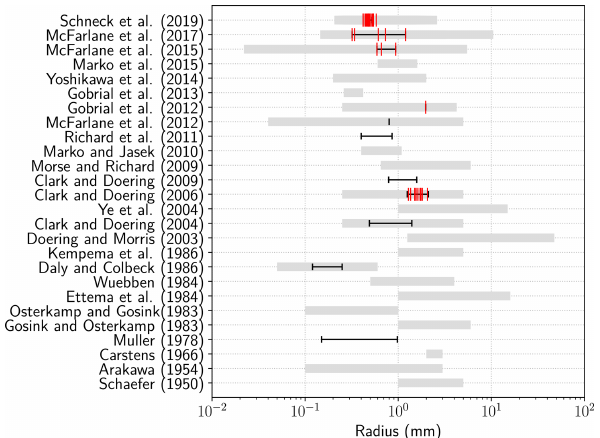
Figure 3. Particle-size ranges (thick grey line), mean range (thin dark line) and log-normal distributions’ mean radius (red vertical ticks) reported in field or laboratory experiments (Schaefer, 1950; Arakawa, 1954; Carstens, 1966; Gosink and Osterkamp, 1983;